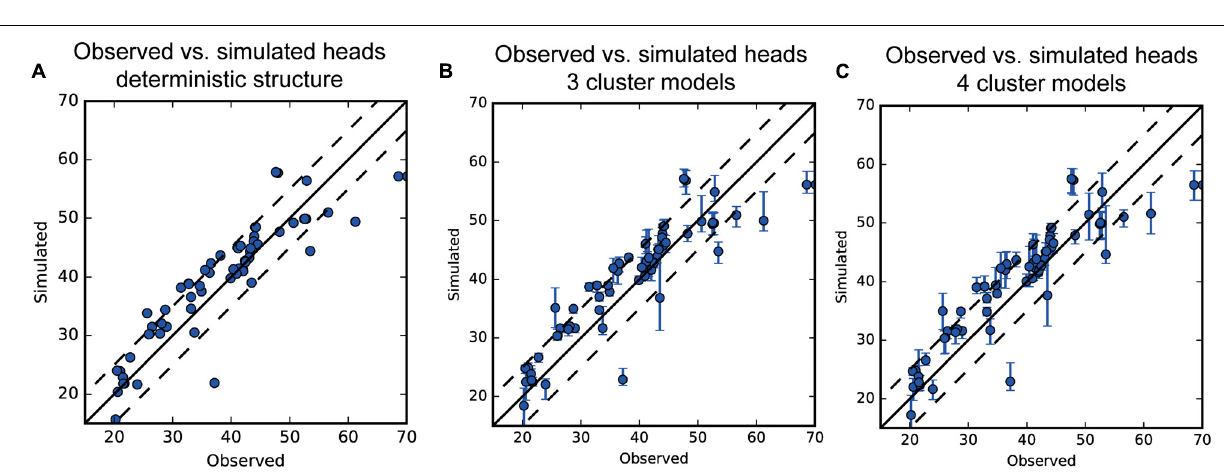
FIGURE 8 | Deterministic structure and TI together with three structural representations generated using SNESIM and SISIM, respectively.